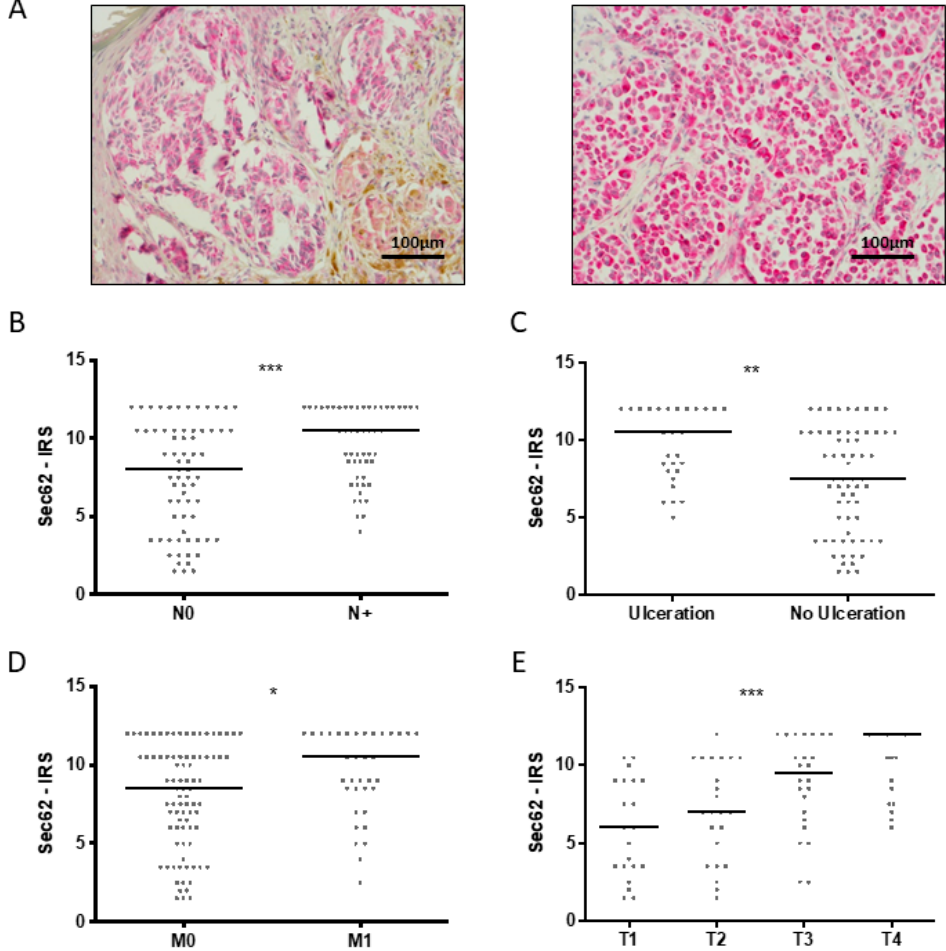
Figure 2. Correlation of SEC62 expression with histopathological features. ( A ) Representative IHC-images of one Sec62-low MM (left image) and one Sec62-high MM (right image); ( B ) Sec62- immunoreactive score (IRS) for MM N0 vs. N1; ( C ) Sec62-IRS for MM with/without ulceration; ( D ) Sec62-IRS for MM M0 vs. M1; ( E ) Sec62-IRS for different T stages. In ( B ) to ( E ), every dot represents one patient, and the median is indicated by a line. Statistics: ( B – D ) Mann–Whitney U test; ( E ) one-way ANOVA test; *— p < 0.05; **— p < 0.005; ***— p < 0.001.